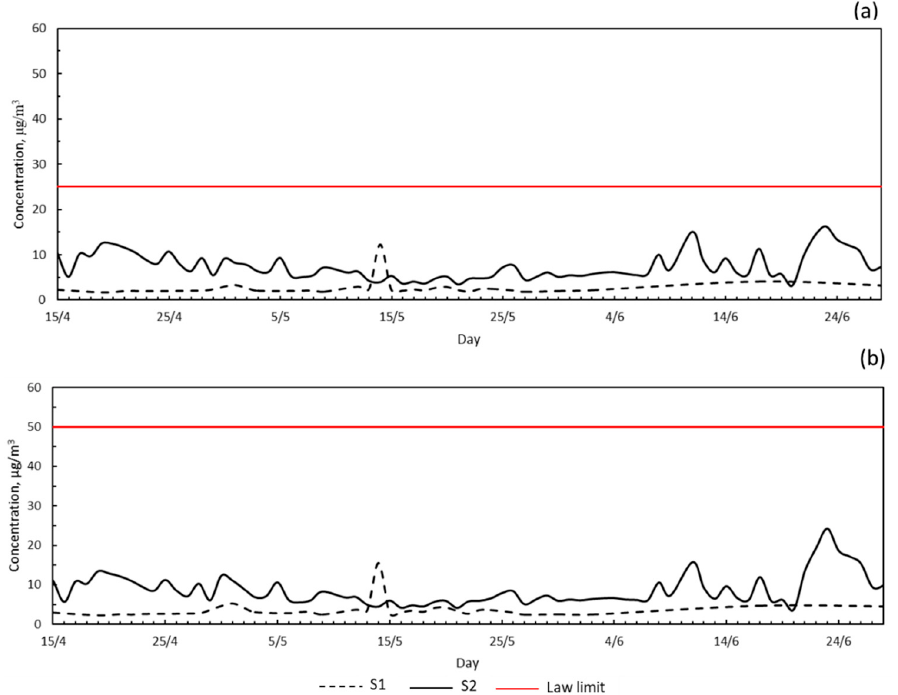
Figure 5. Daily average concentration of ( a ) PM 2.5 and ( b ) PM 10 measured in S1 (black dashed line) and S2 (solid black line) in the period 16/04/2021–05/07/2021. Red solid line represents the law limit concentration for PM 10 and PM 2.5 according to D.Lgs 155/2010.